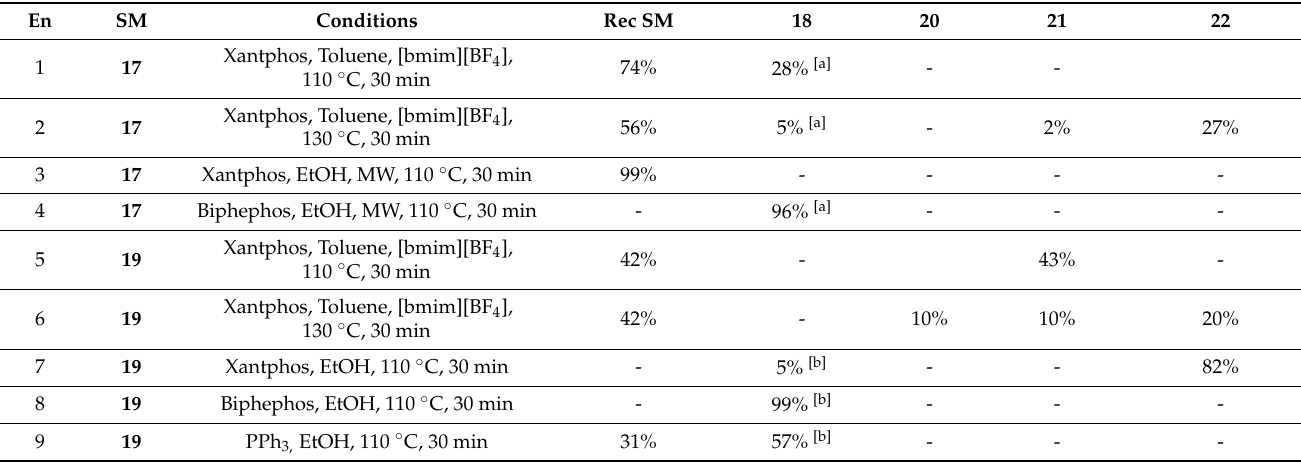
Table 2. HAM optimisation for Hyacintacine A 2